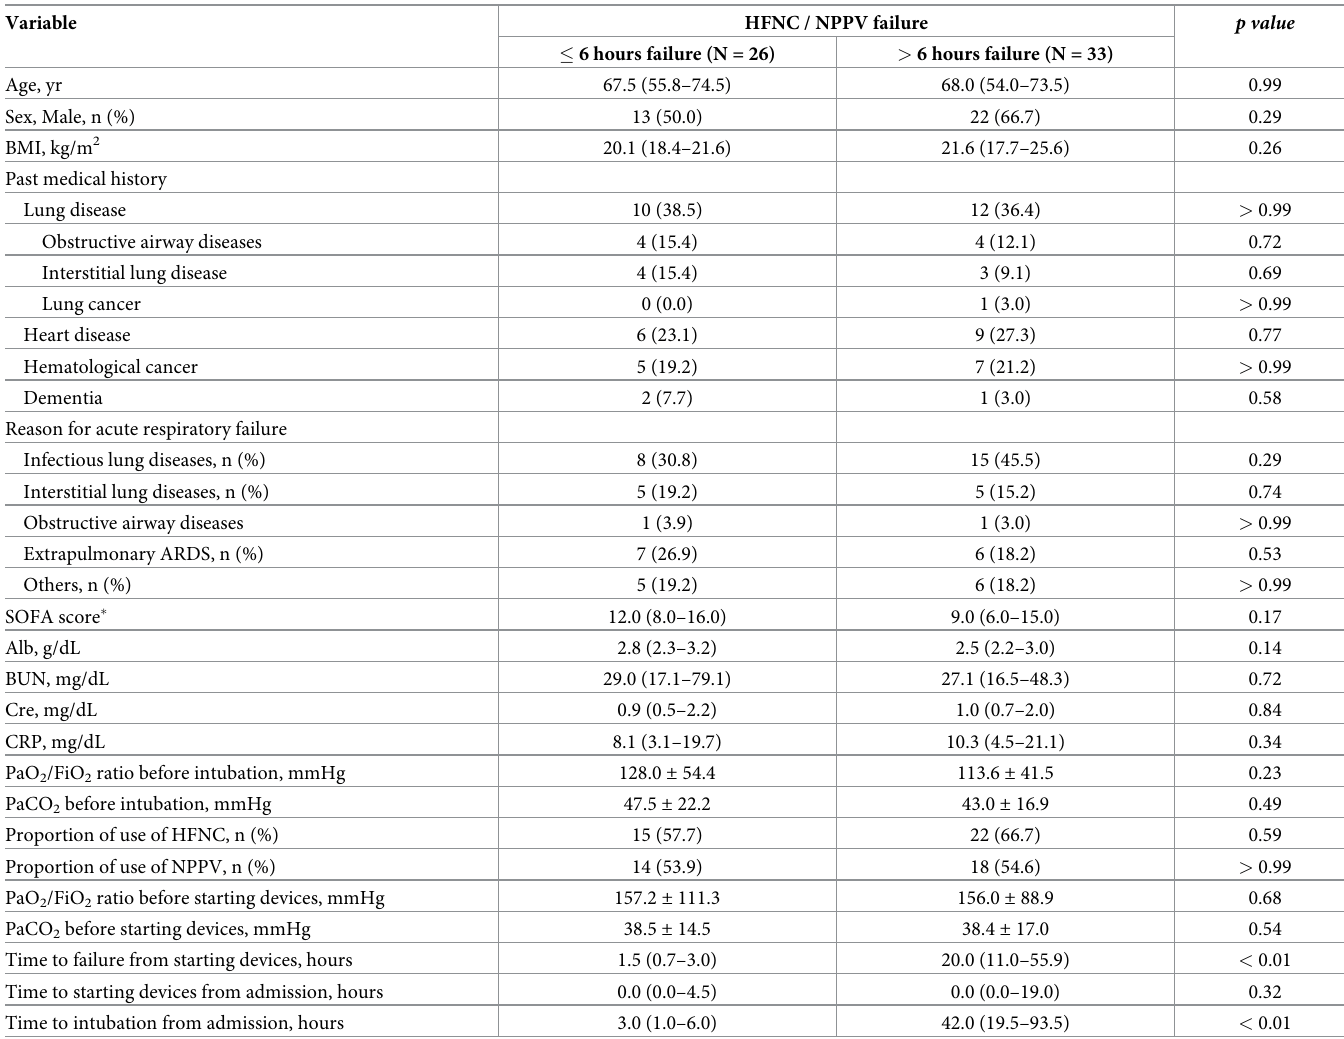
Table 1. Baseline characteristics of the